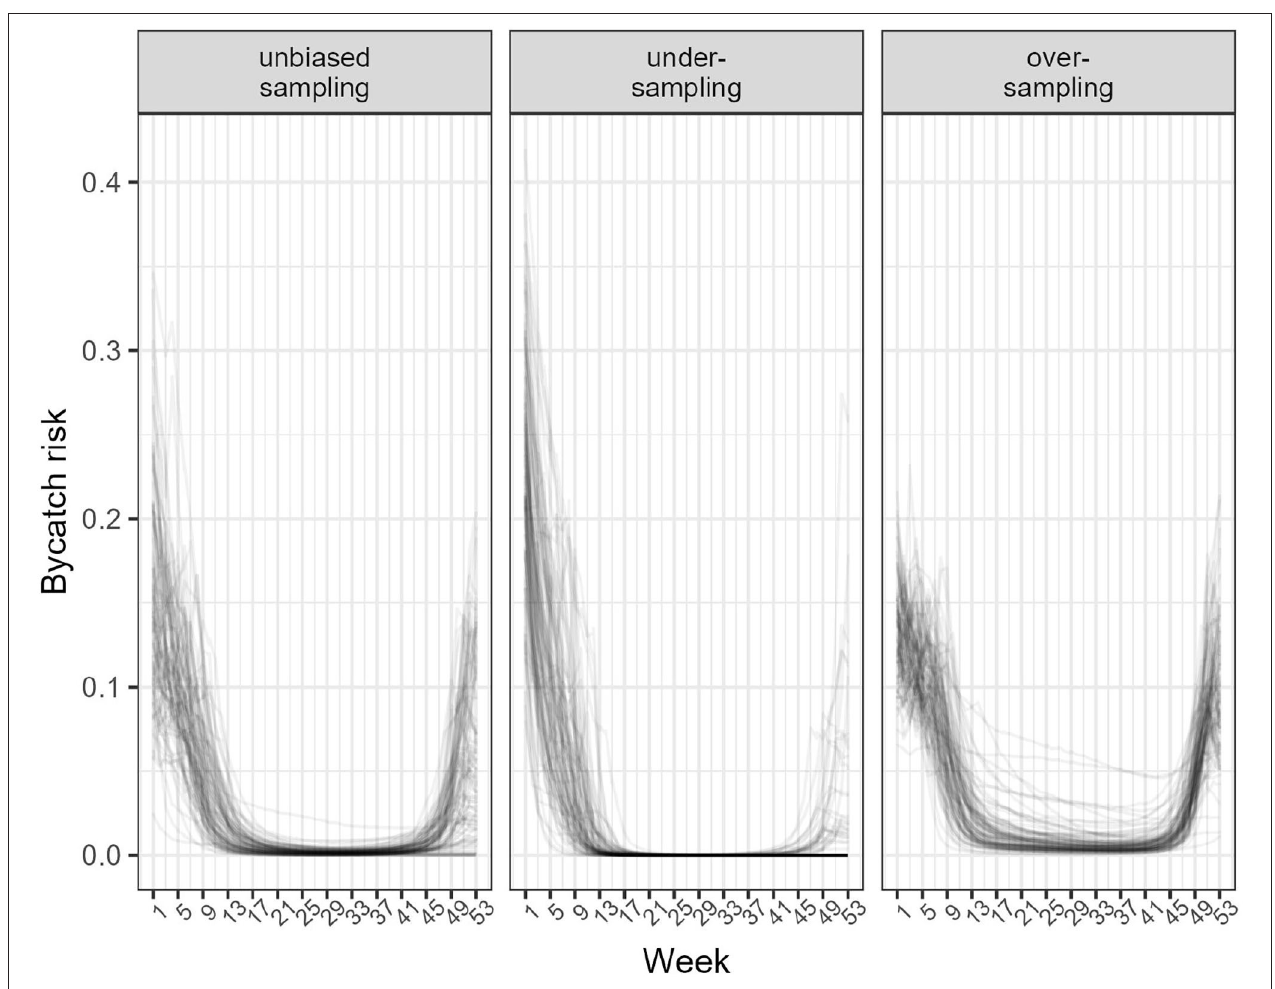
FIGURE 5 | Estimated temporal pattern in mean bycatch risk from the model-based approach. Left: data sampling was unbiased. Middle: Under-sampling. Right: Over-sampling. The model-based approach recovered the correct pattern overall, but overestimated risk in the over-sampling scenarios when risk was, in fact, nil but no data were